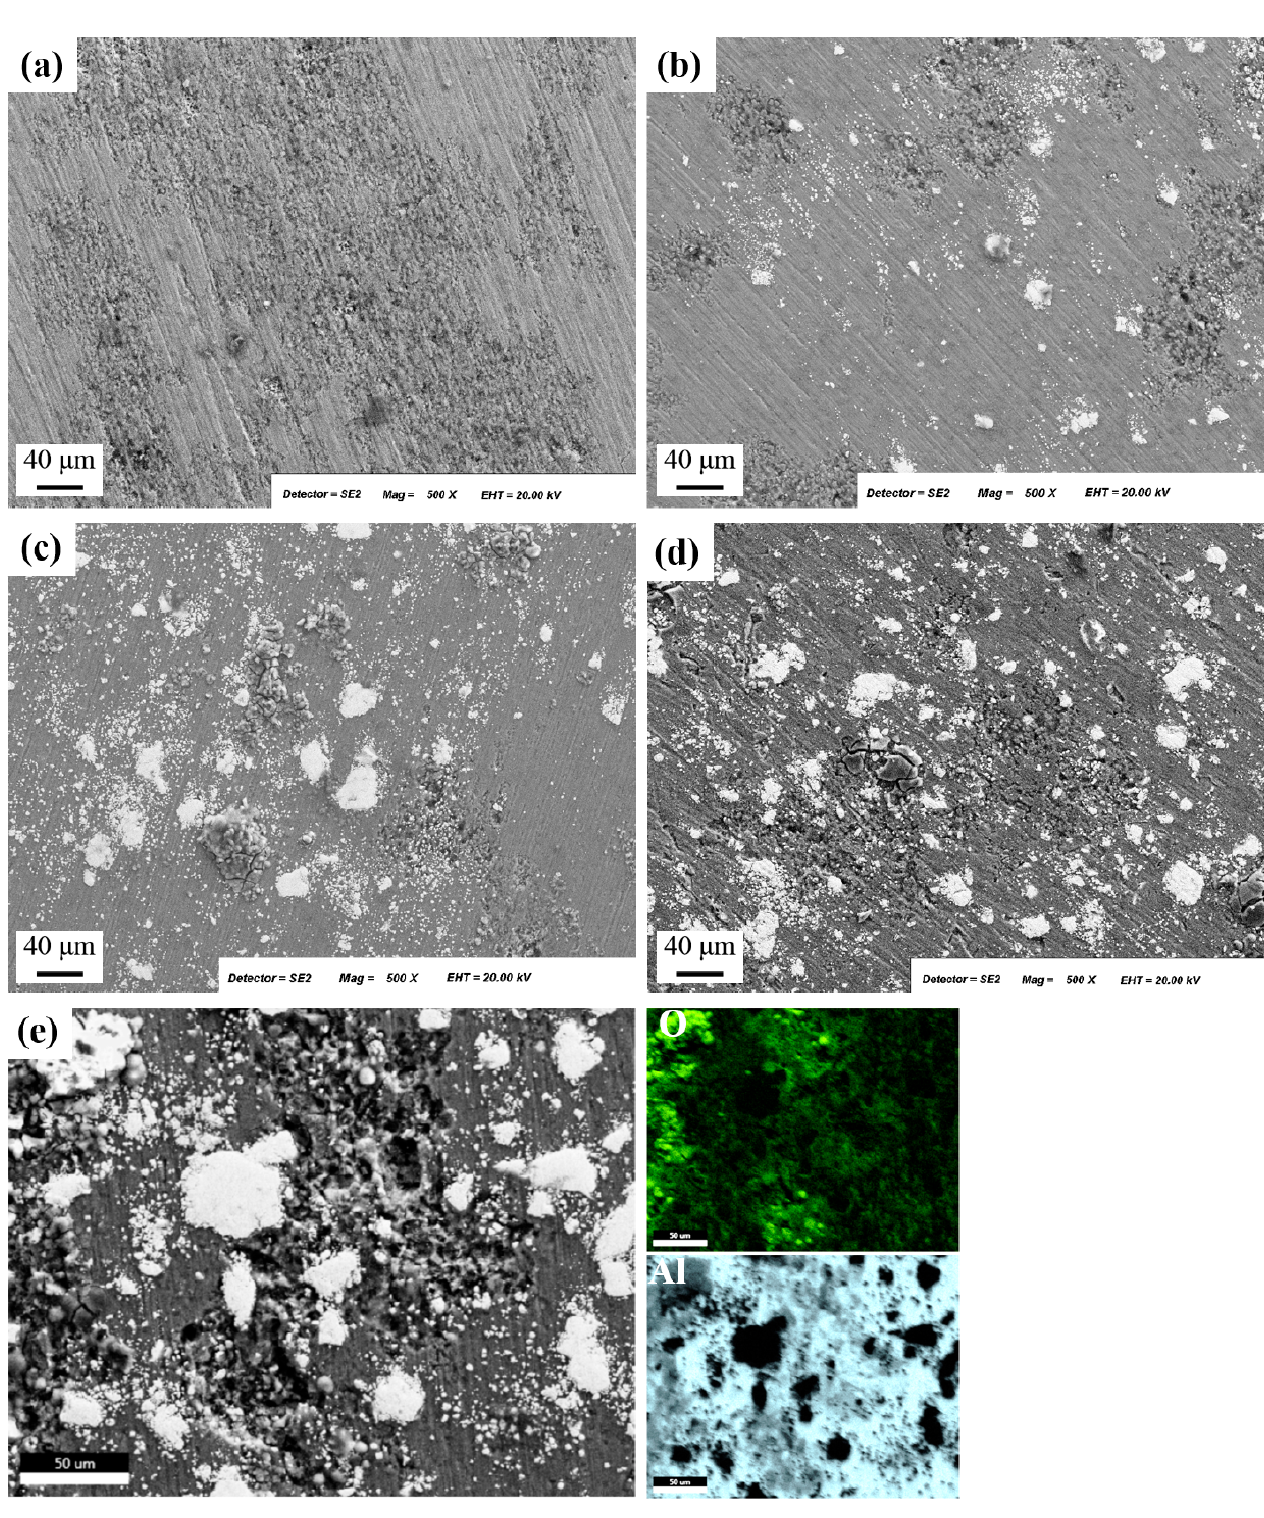
Figure 7. Microstructure of the corroded surface (SE mode) after polarisation in aerated 3.5% NaCl solution: ( a ) Al, ( b ) Al ‐ 1 vol% HEA, ( c ) Al ‐ 3 vol% HEA, and ( d , e ) Al ‐ 5 vol% HEA with elemental map.